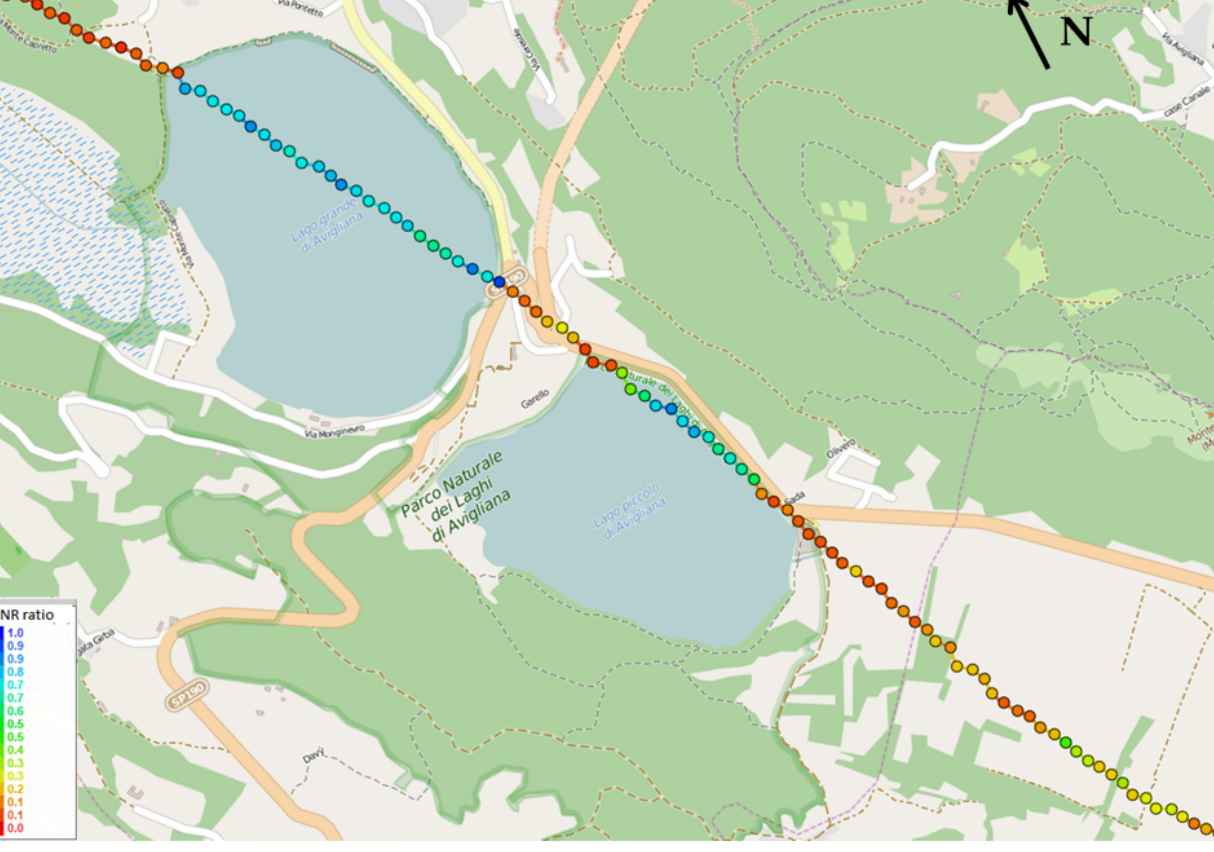
Figure 10. Specular points of PRN 30 over the Avigliana lakes. The color is proportional to the SNR ratio between the left-hand circular polarized (LHCP) reflection and the direct GPS